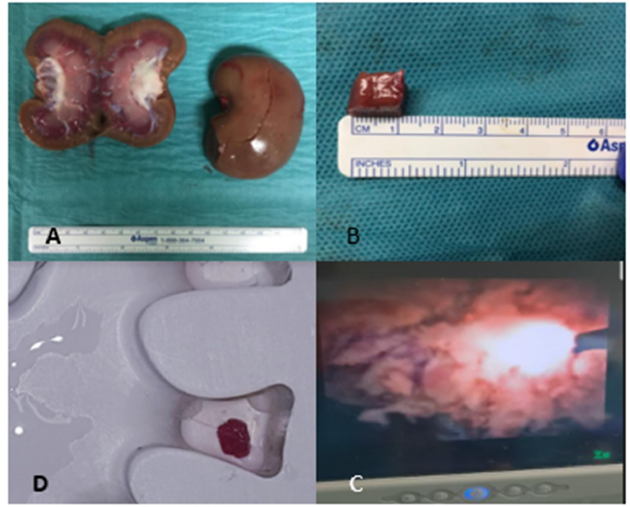
Figure 1. Experiment setup showing ( A ) Porcine kidney and section ( B ) 1 cm specimen of tissue ( C ) tissue block in collecting system model ( D ) Endoscopic view during tissue laser ablation.